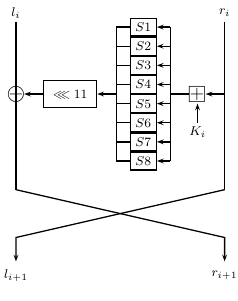
Figure 1: One round of GOST. The symbols (cid:1) , ⊕ , and ≪ j are used for modular addition, bitwise addition, and cyclic left rotation by j bits,